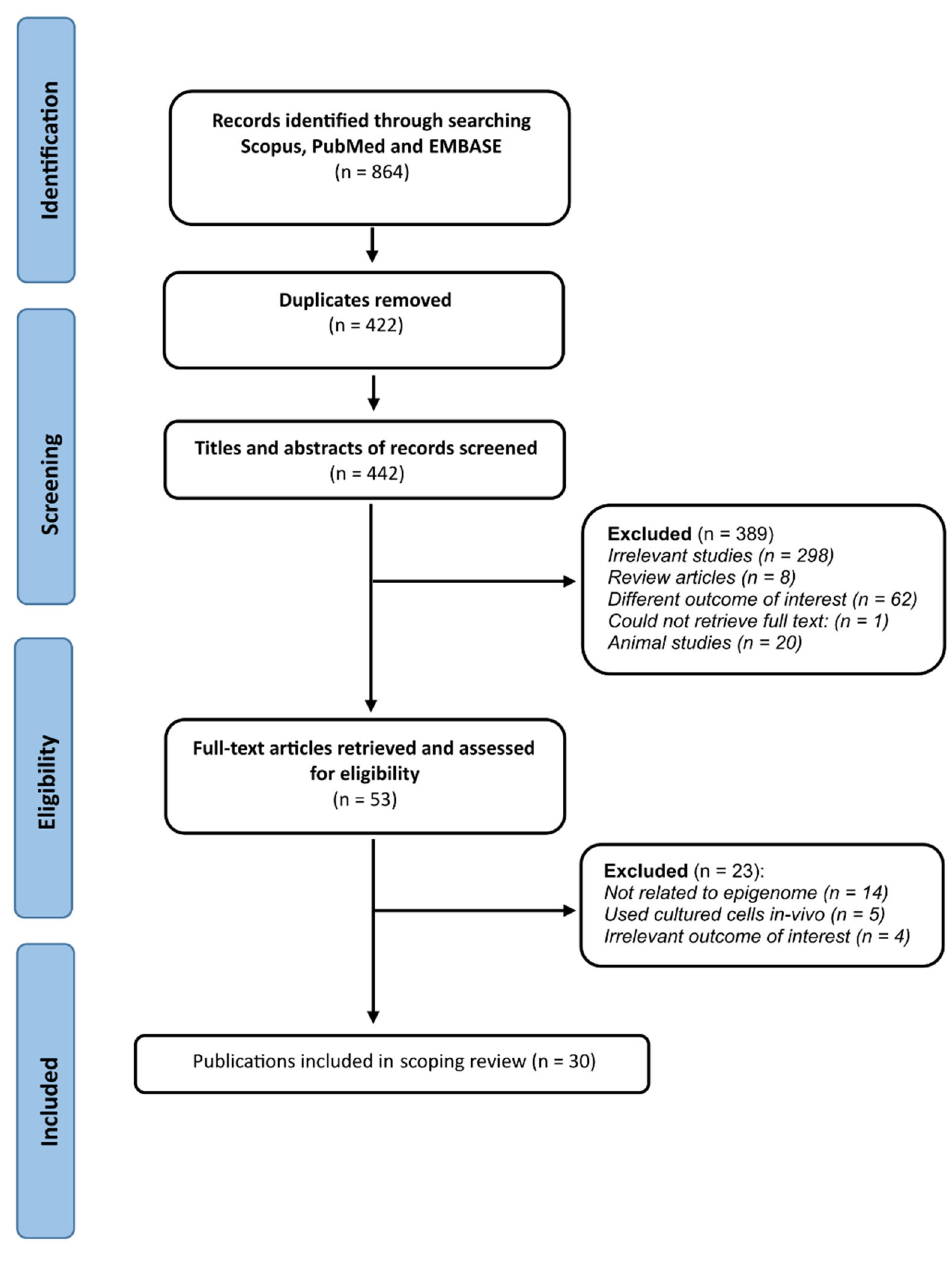
Figure 2. Preferred Reporting Items for Systematic Reviews and Meta ‐ Analysis (PRISMA) flow diagram detailing study screening and selection.